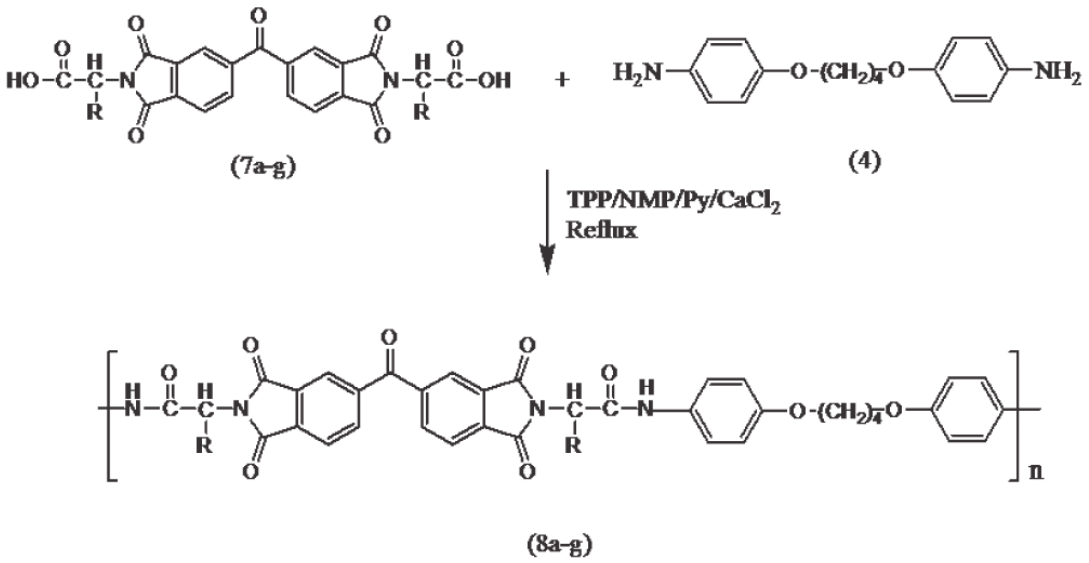
Scheme 3: Synthesis of PAIs 8a–g .